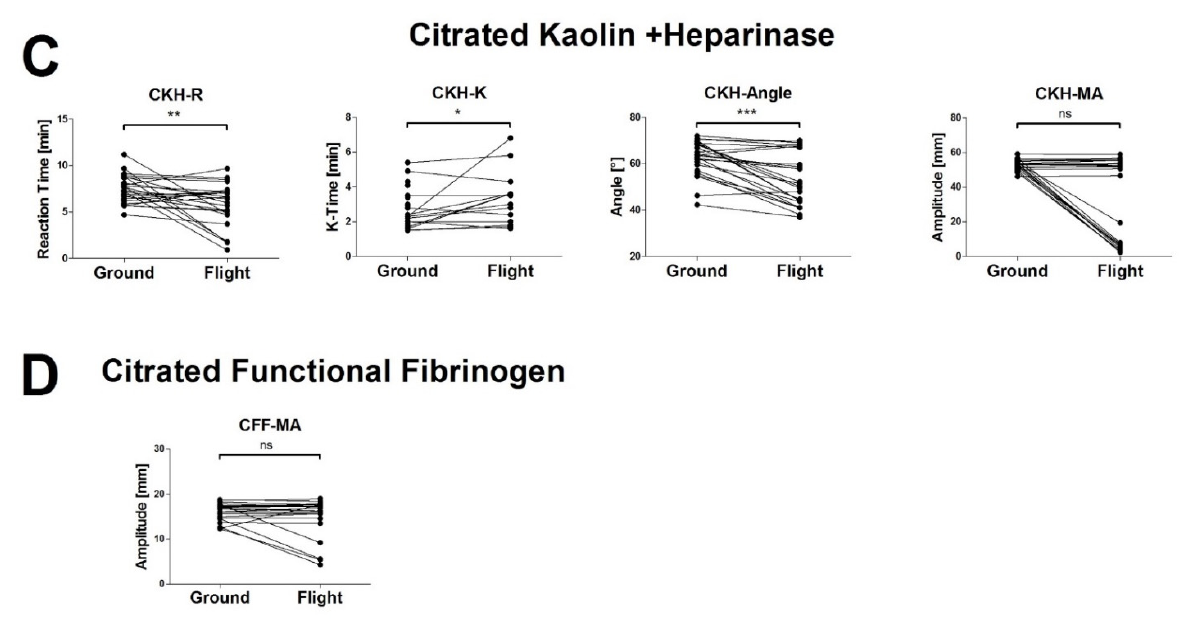
Figure 2. Viscoelastic haemostatic measurements from healthy volunteers on the ground and in-flight. Corresponding results from the same donor are connected with a line. Paired t -tests were performed to assess differences between both measurement conditions. Note that in many cases, statistical analysis returned no significant differences between time points. However, when looking on individual data points, measurements yielded different results in-flight and on the ground. CK, Citrated Kaolin; CRT, Citrated Rapid TEG; CKH, Citrated Kaolin + Heparinase; CFF, Citrated Functional Fibrinogen; * p < 0.05; ** p < 0.01; *** p < 0.005; ns, not significant.